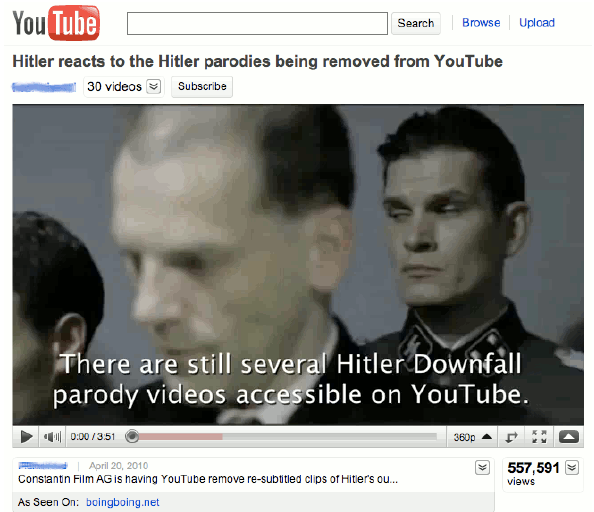
Figure 2: The video “Hitler reacts to the Hitler parodies being removed from YouTube.” Screenshot taken on July 10,